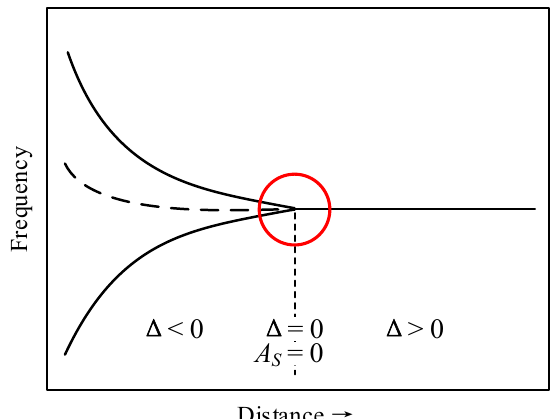
Figure 4. Operating frequency versus distance between the Tx and Rx coils at complete matching (when ∆ = 0, A S = 0).